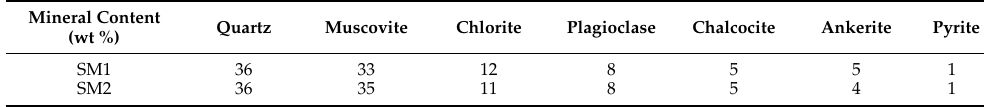
Table 1. Mineral composition of slate samples.